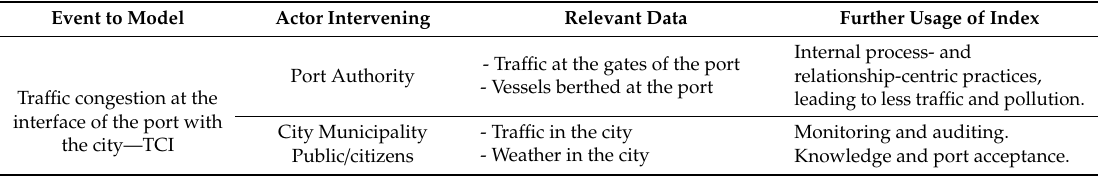
Table 2. Representation of a smart port-city composite index use-case.